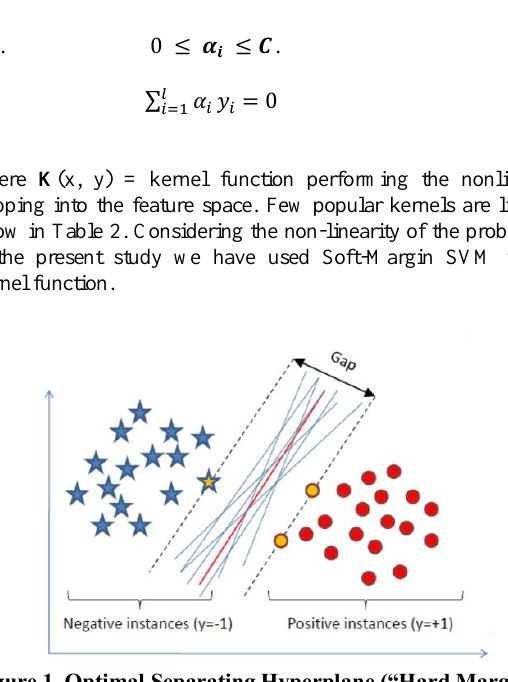
Figure 1. Optimal Separating Hyperplane (“Hard Margin”